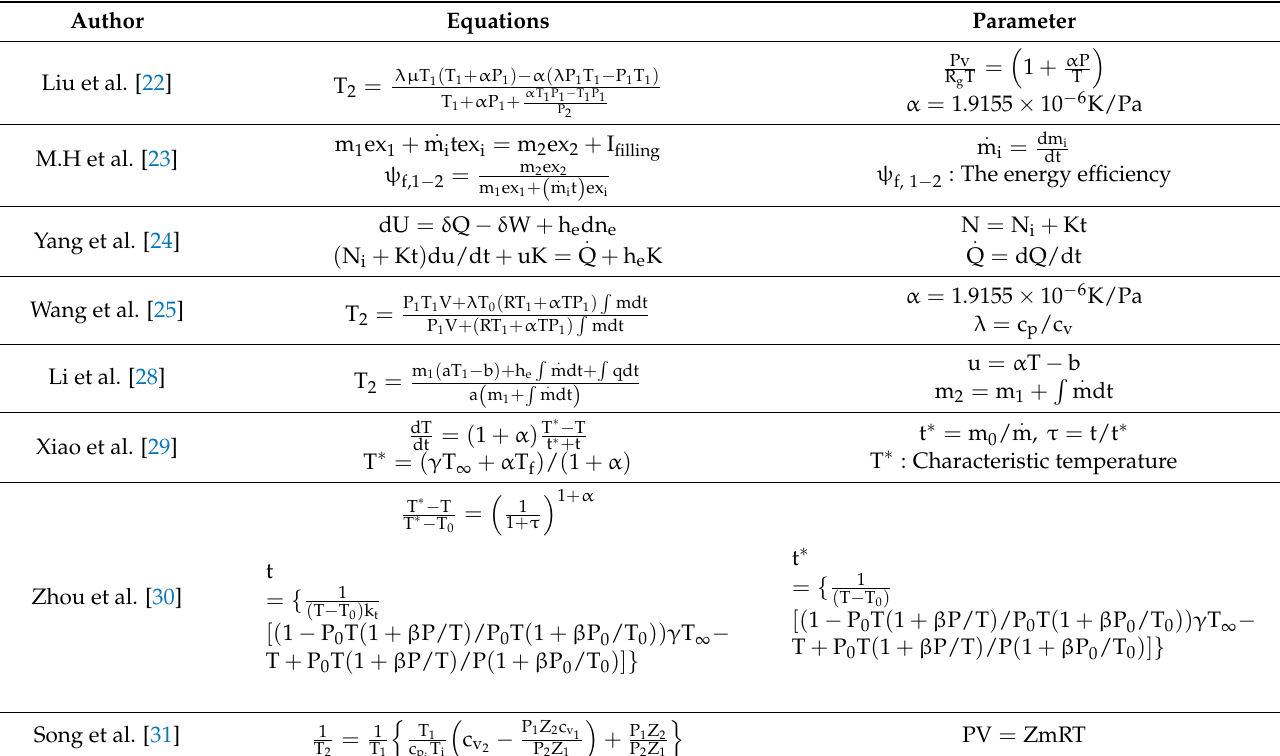
Table 3. Theoretical studies of final